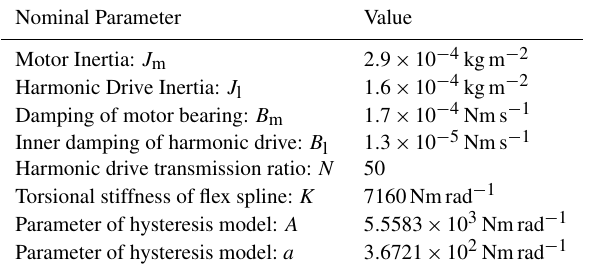
Table 1. The Inherent Parameters of Harmonic Drive System (Gandhi et al., 2001).